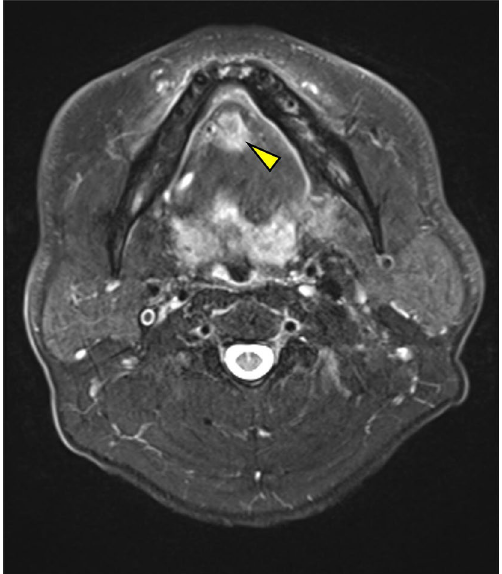
Figure 1. T2-weighted magnetic resonance (MR) image showing median lingual lymph node metastasis (LLNM) (arrowhead) in the lingual